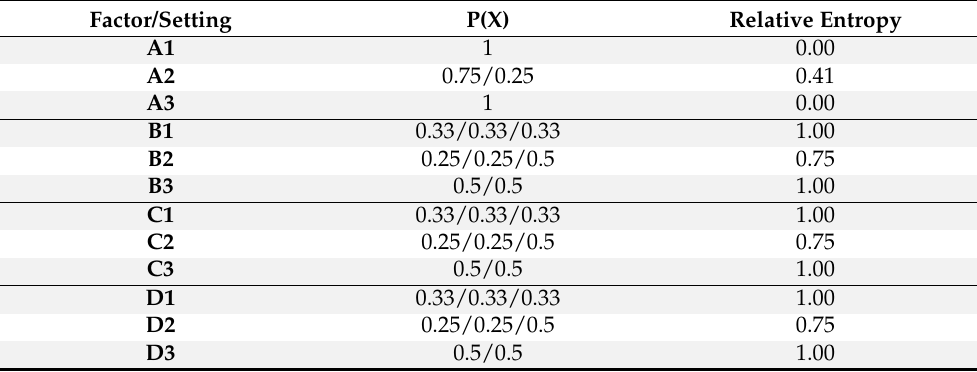
Table 2. Relative entropy for clustered factor